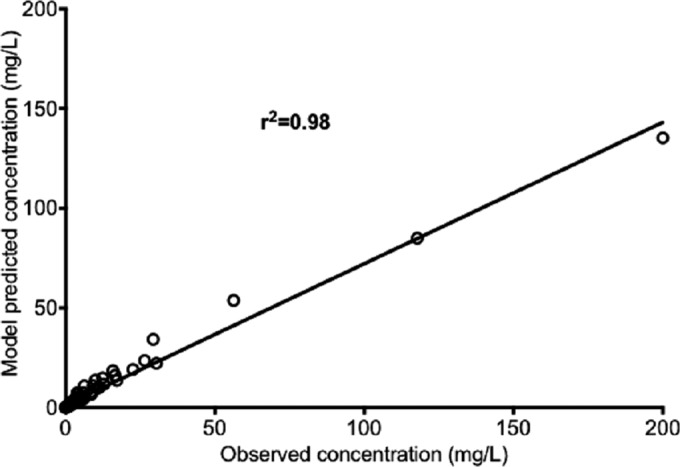
Amikacin concentrations as achieved in the HFS-TB. The two-compartment pharmacokinetic model predicted versus observed amikacin concentrations demonstrate a high r2 value, which means that the model described the concentration adequately.